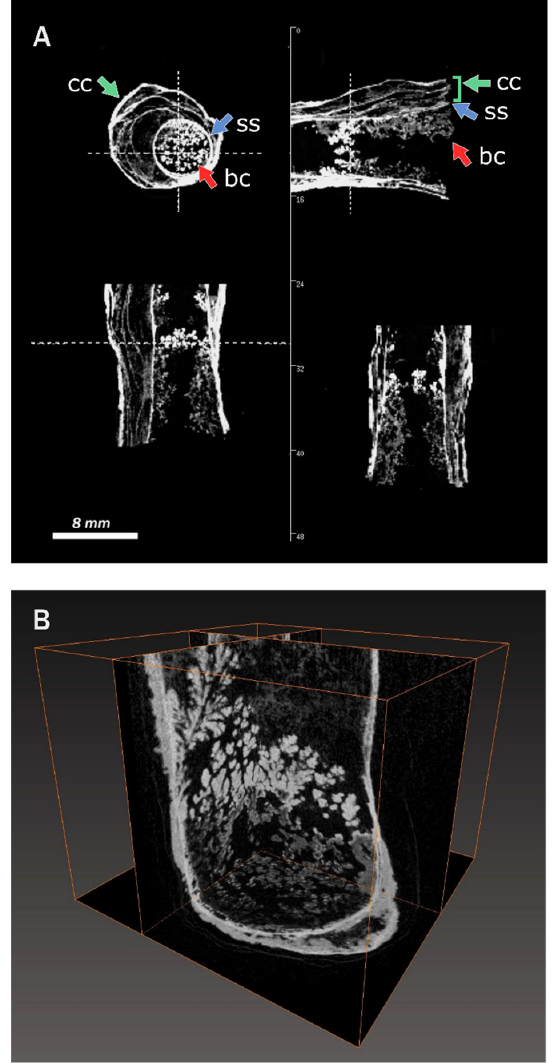
Figure 4. Inner structure of the studied stalactite studied by means of microCT-RX. ( A ) Orthogonal sections showing the main structural elements (cc: cone-crust; ss: soda-straw; and bc: branching of coralloids). ( B ) 3D reconstruction of the stalactite.